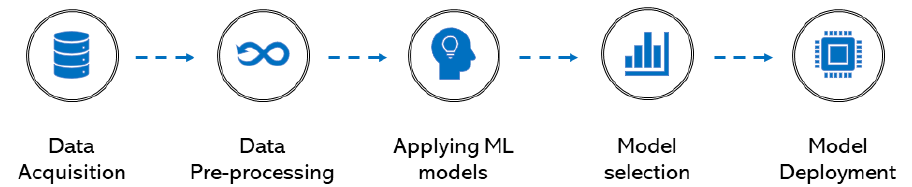
Figure 6. Health status prediction module’s development